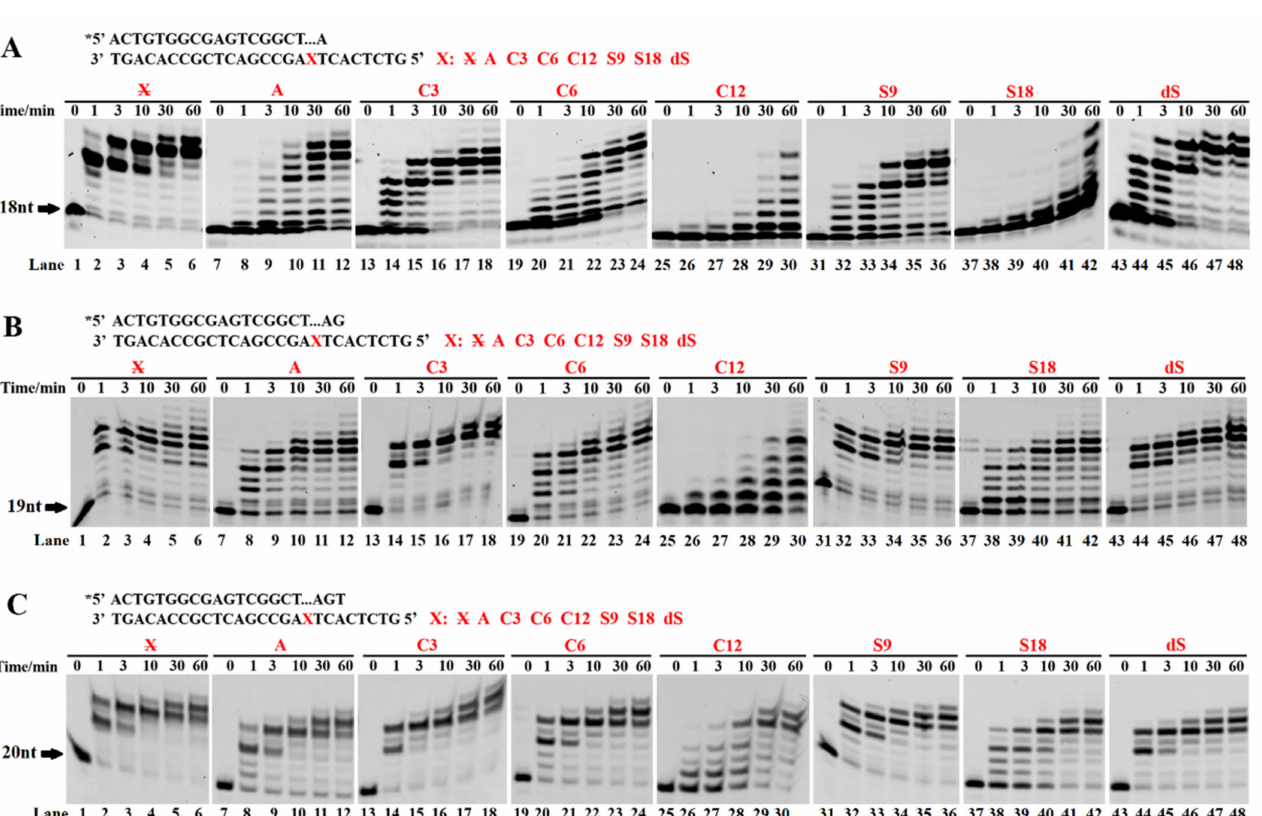
Figure 3. Primer extension with increasing pairing numbers of 3 (cid:48) base pairs with a bulging spacer. The PT DNA substrates are shown at the top of the figure. The letter X denotes a skipped base A and spacers C3, C6, C12, S9, S18, and dS. The symbol X denotes the normal DNA template. The PT DNAs, with 3 (cid:48) base pairs of 1 bp ( A ), 2 bp, ( B ) and 3 bp ( C ) after the bulging spacer or base A, were used as substrates to characterize the extension reactions. The PT DNA substrates were incubated with 0.1 µ M Dbh and dNTPs at 45 ◦ C for 0, 1, 3, 10, 30, and 60 min. Asterisks denote the terminal fluorescent group